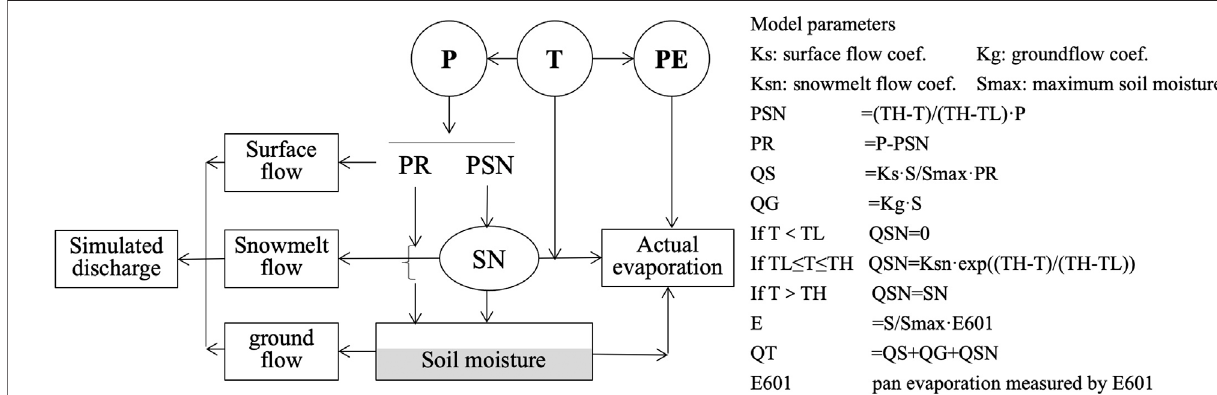
FIGURE 2 | The model structure and principle of the RCCC-WBM.